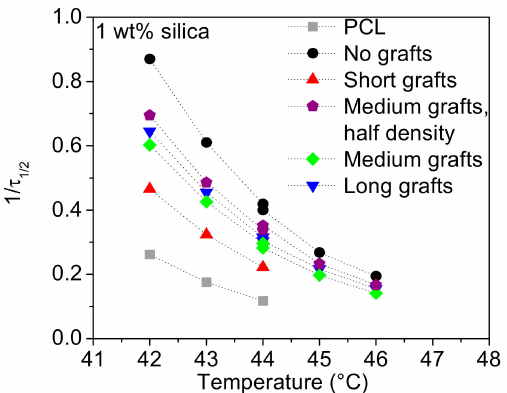
Figure 9. The inverse of half-time of crystallisation versus crystallisation temperature for PCL / silica composites based on the PCL80